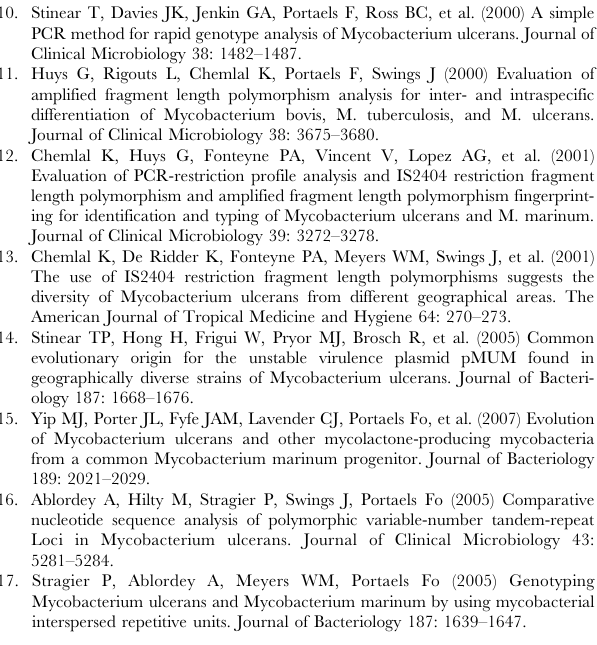
Table S1 SNPs detected among four M. ulcerans genomes. Coordinates correspond to Agy99 finished genome sequence